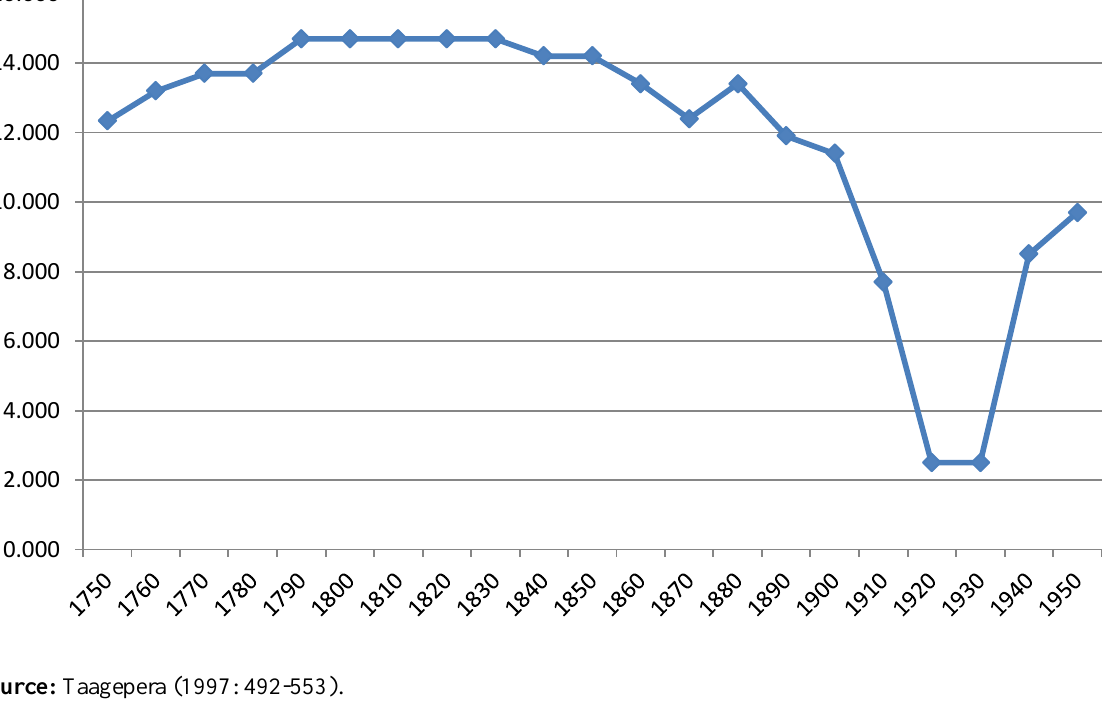
Figure 2. Territorial Expansion, Contraction and Re-expansion of China, 1750-1950, thousand km 2